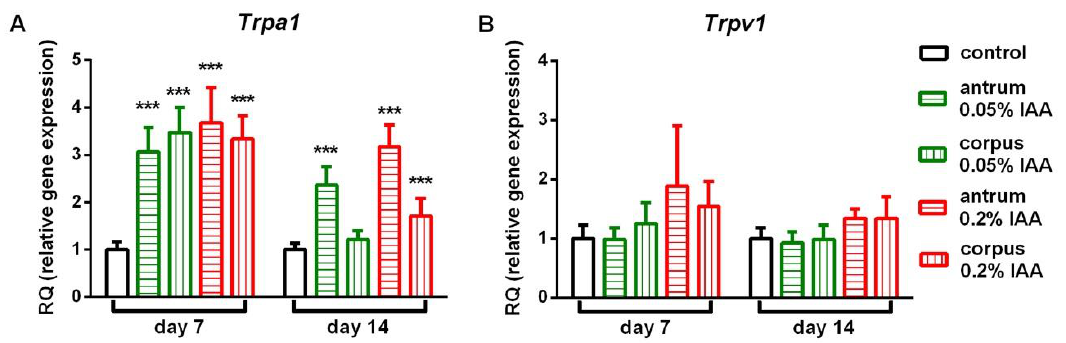
Figure 7. Relative gene expression of Trpa1 and Trpv1. mRNA levels of ( A ) Trpa1 were significantly upregulated after 0.05% and 0.2% IAA treatment, whereas ( B ) Trpv1 gene expression did not